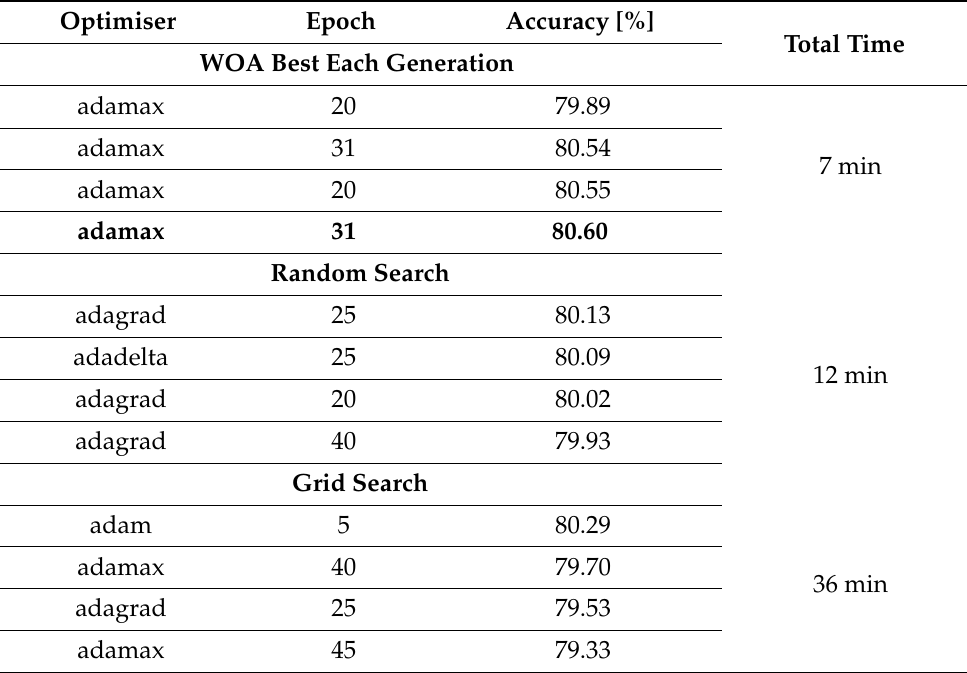
Table 4. Reuters, epoch (0–50), discrete optimiser, batch